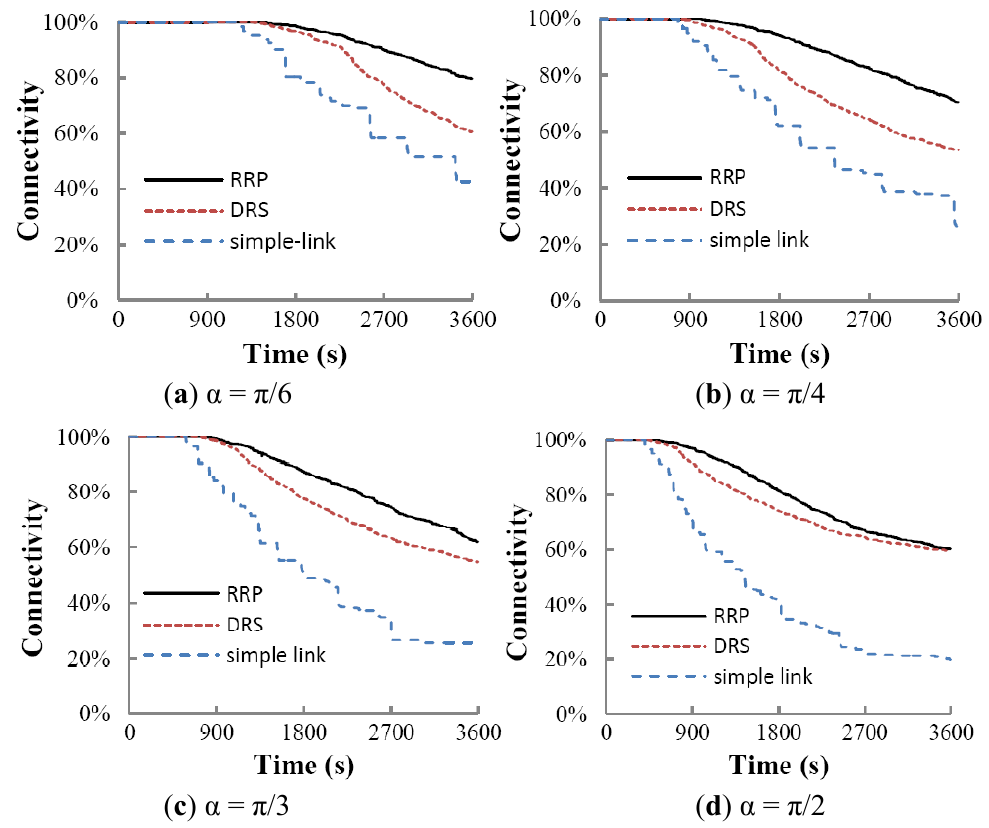
Figure 9. Connectivity vs. time under different scanning angles.